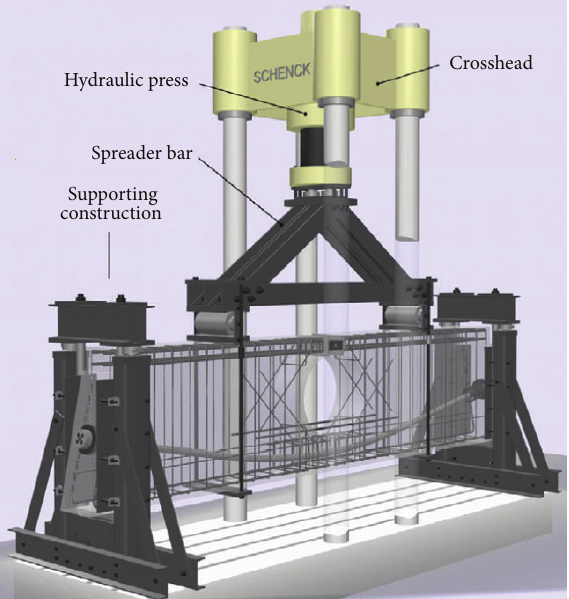
Figure 2: 3D CAD model of the test stand.